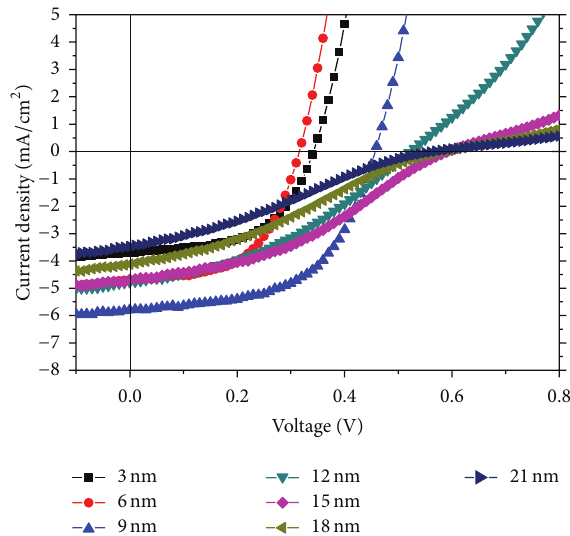
Figure 2: The 𝐽 - 𝑉 characteristics of devices (ITO/SubPc/C 60 (30 nm)/BCP (10nm)/Ag) with different SubPc layer thichnesses (3 ∼ 21nm).